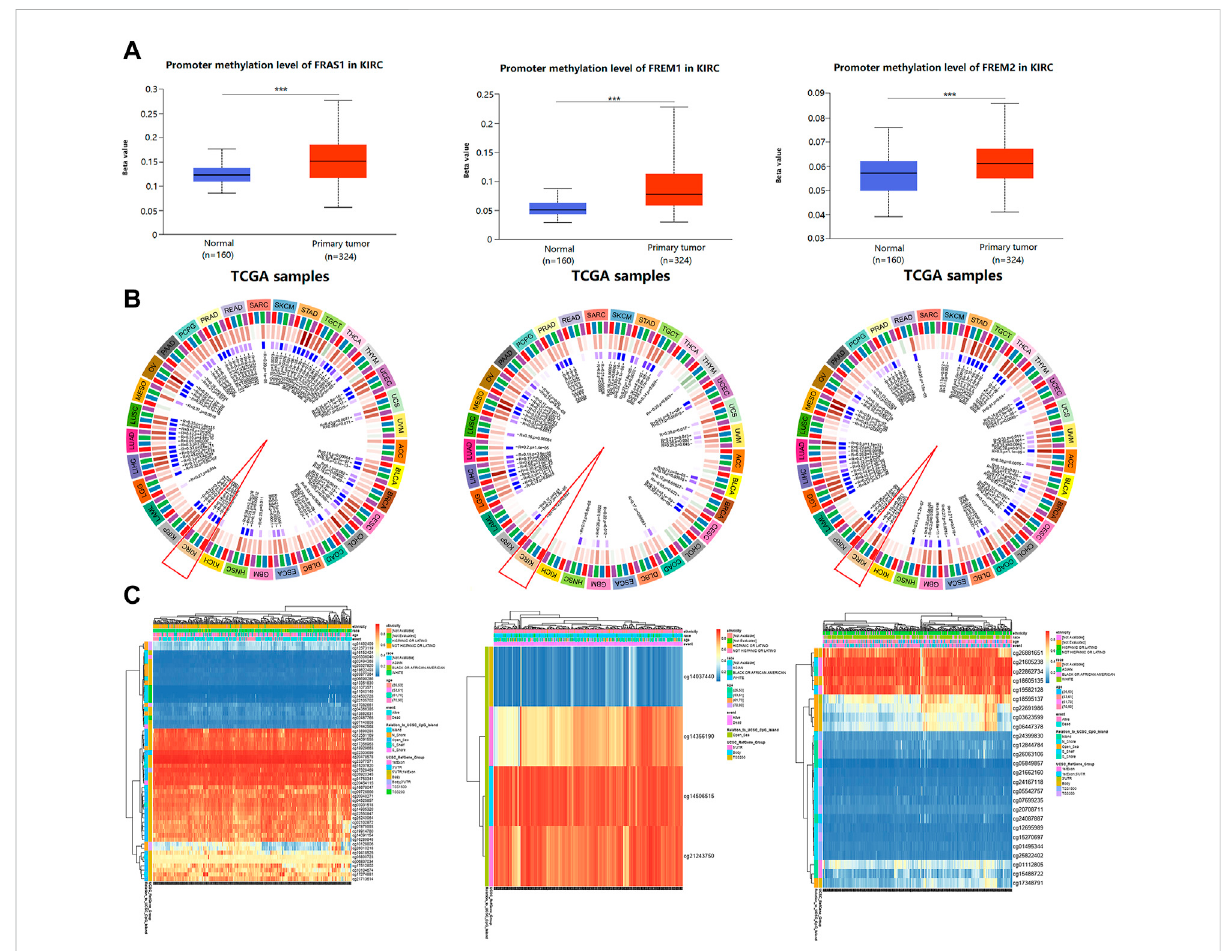
FIGURE 9 The correlation between FRAS/FREM expression and DNA methylation. (A) The promoter methylation levels of FRAS1, FREM1 and FREM2 in KIRC tissues vs. normal tissues. (B) The correlations between FRAS1, FREM1, FREM2 expression and three DNA methyltransferases (DNMT1, DNMT2 and DNMT3A). (C) The heat map of DNA methylation of FRAS1, FREM1, FREM2 in